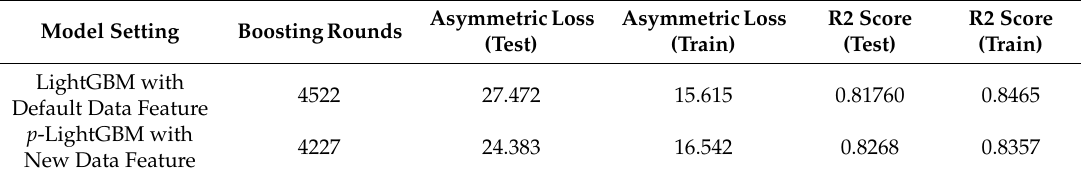
Table 4. Predictions for di ff erent types and di ff erent combinations data types.